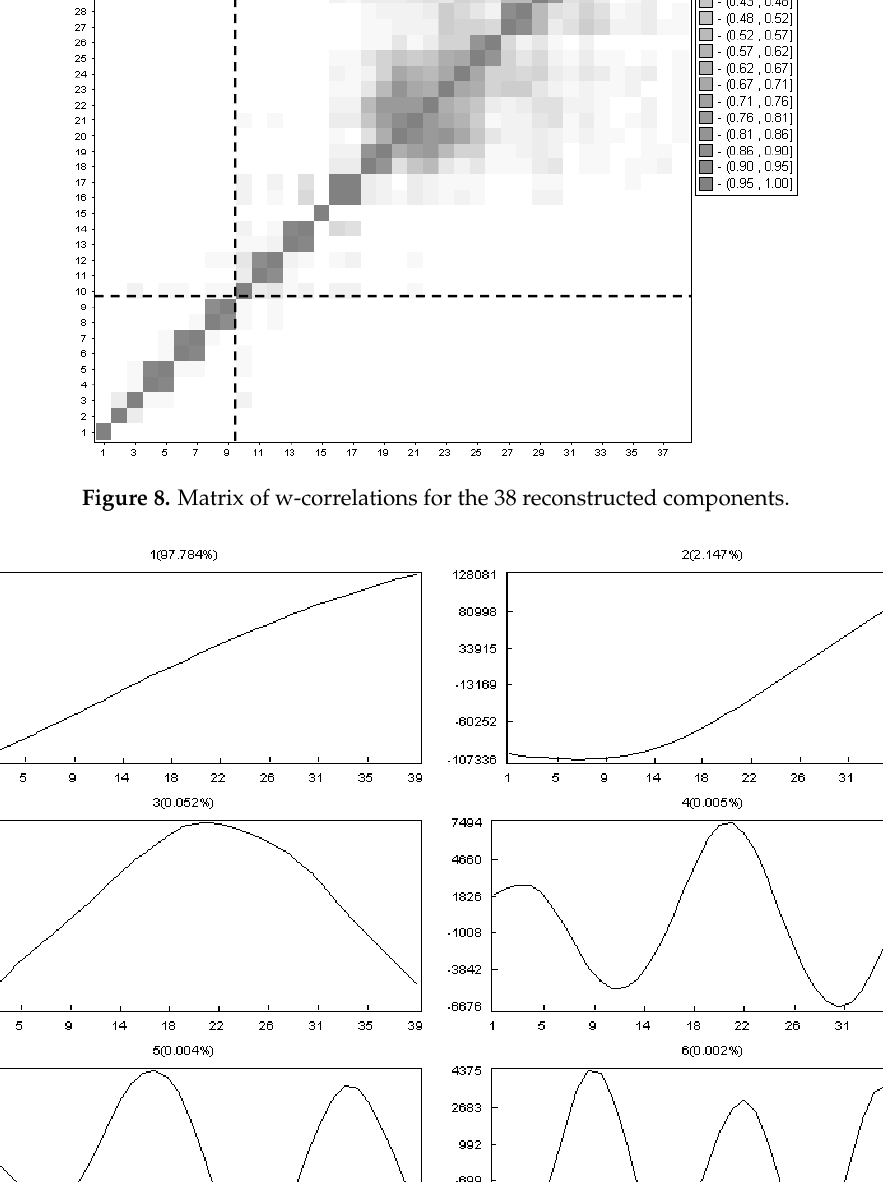
Figure 9. The first six principal components.